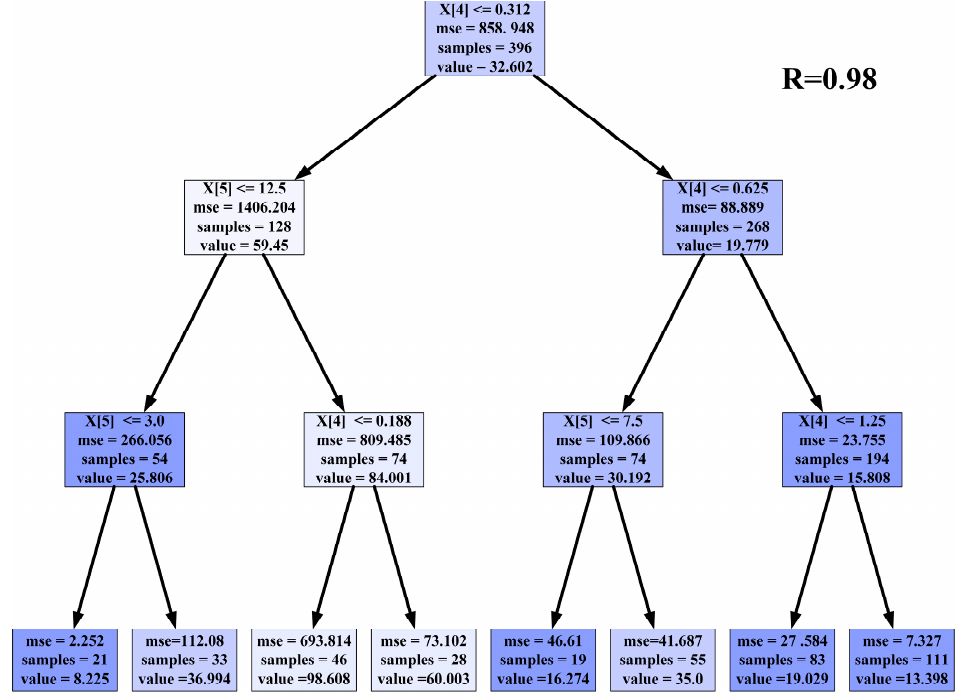
Figure 10. The visualization of a DT for K c . Note that X[4] and X[5] represent T/2R and G sand / G clay , respectively.